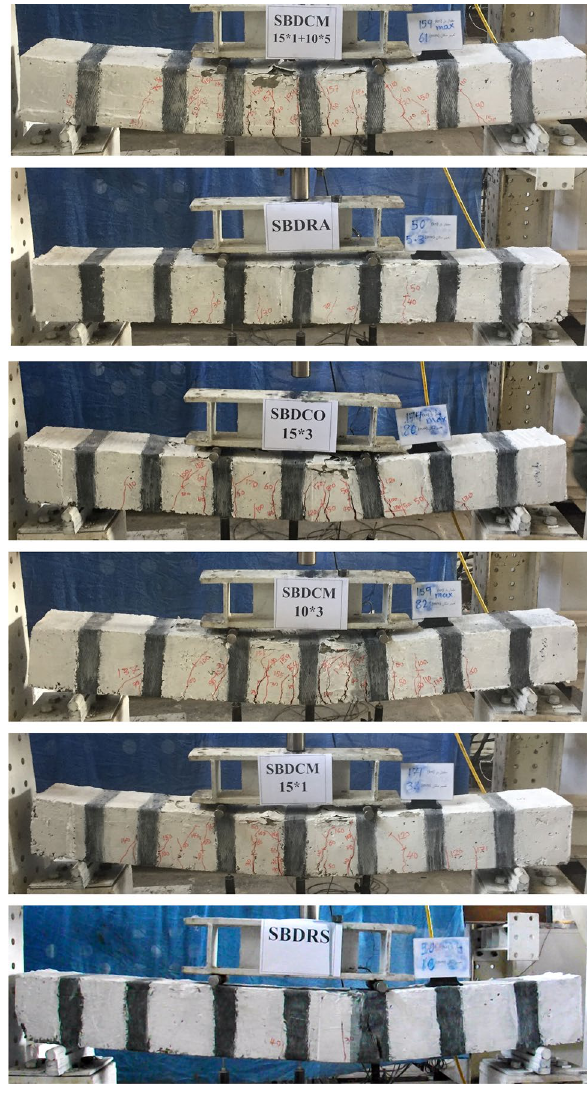
Fig. 10 Comparison of load–displacement for all specimens